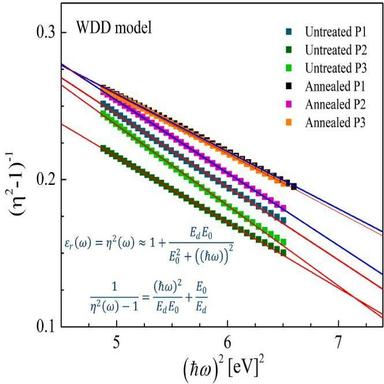
Graphical relationship between (ℏω) 2 and (η2(ω) − 1) − 1 according to the WDD model.